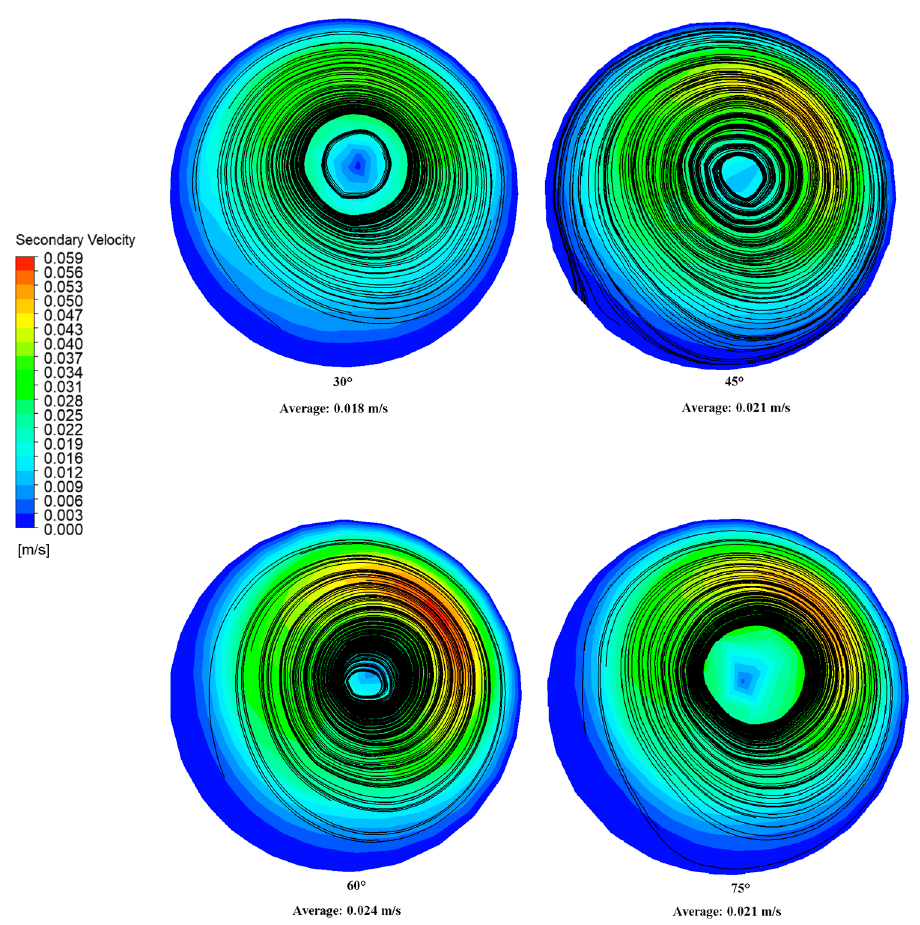
Figure 7. Secondary velocity contours and cross-flow streamlines 50 mm from the anastomosis toe.